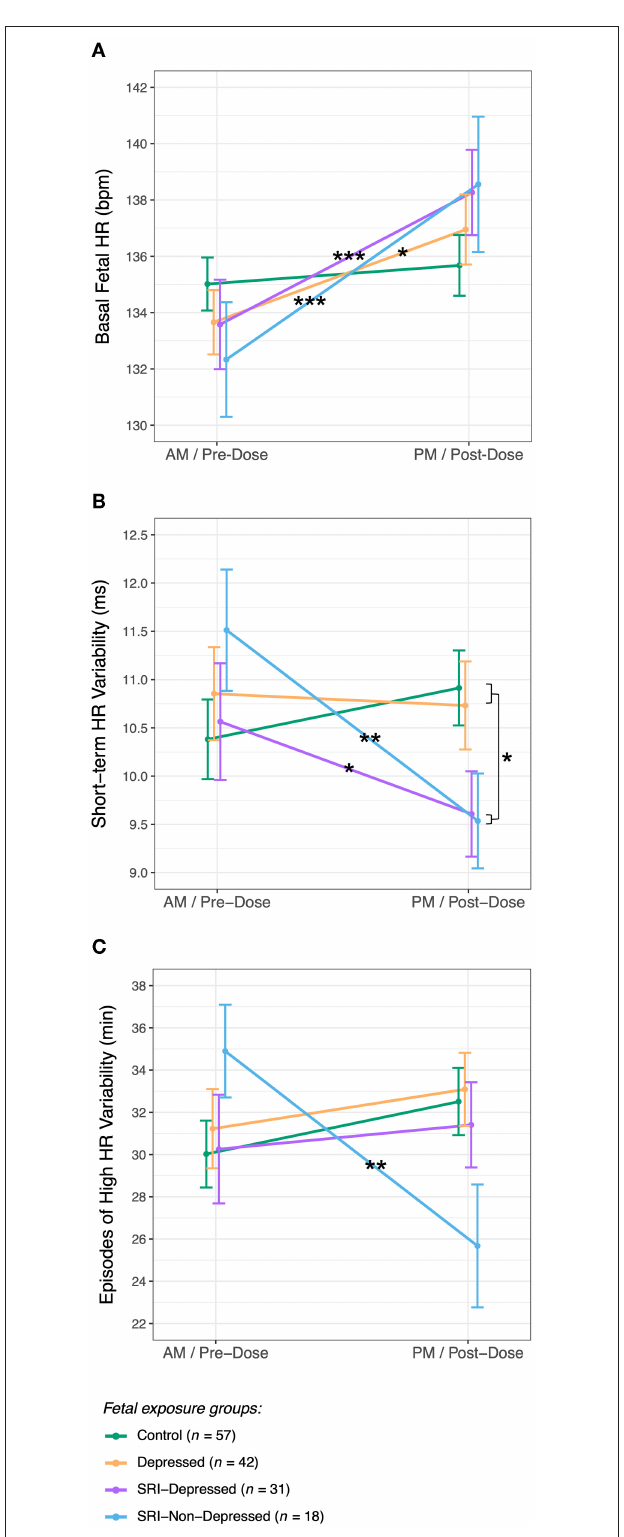
FIGURE 3 | Fetal HR and HR variability (mean ± SE) for each exposure group across AM/pre-dose and PM/post-dose fetal assessments for (A) basal fetal HR, (B) short-term variability, and (C) episodes of high fetal HR variability ( post hoc test significance levels: * p < 0.05, ** p < 0.01, *** p <